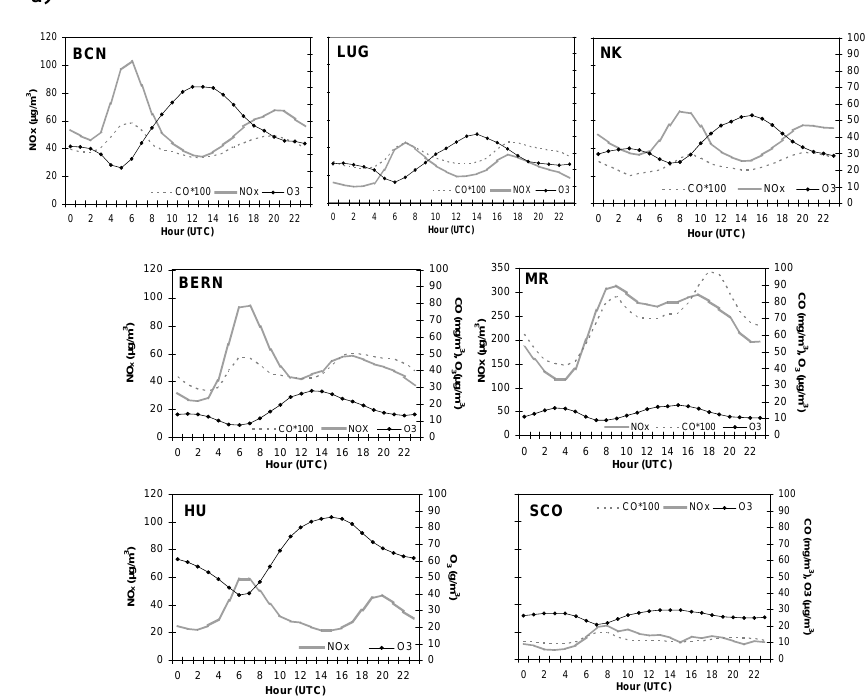
Fig. 2a. Daily cycle of: gaseous pollutants concentrations (CO, NO x and O 3 ) levels for each monitoring site.